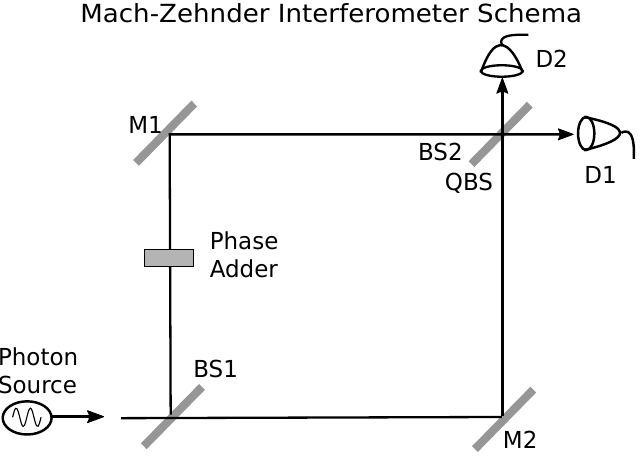
Figure 9. Schematic diagram of the Mach–Zehnder